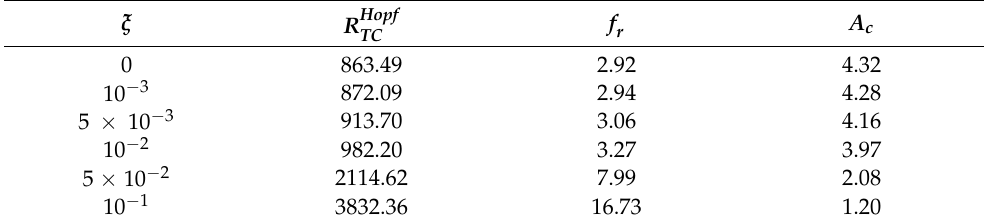
Figure 5. Perturbation profiles Ψ Da e = 10 − 4 , Le = 2, D u = S r = 0.1, ξ = 0 and ε = 1: R Hopf ( b ) p i = − 27.13. Table 5. Effects of acceleration parameter ξ on the threshold of the Hopf bifurcation in an infinite vertical layer for Da e = 10 − 4 Le = 2 D u = S r = 0.1, and ε =